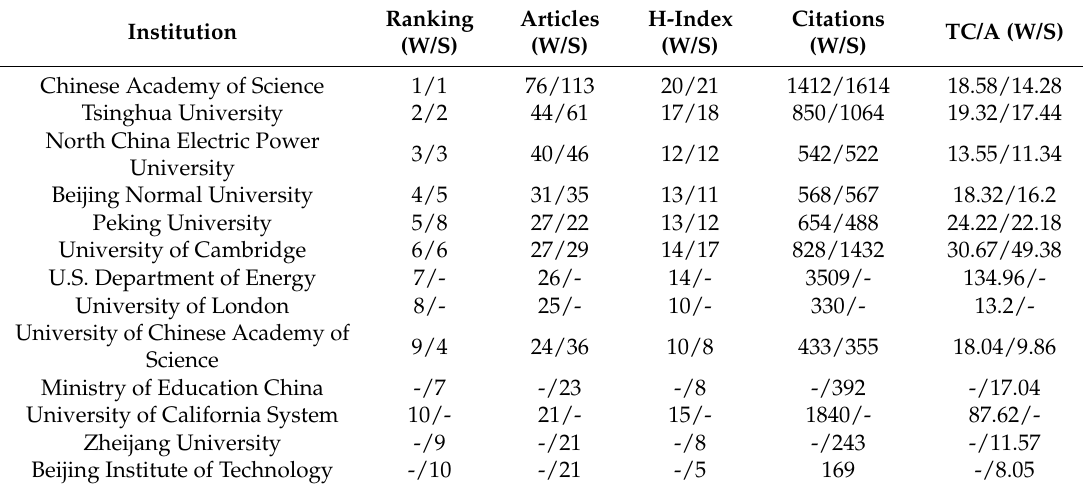
Table 8. Distribution of articles by institution